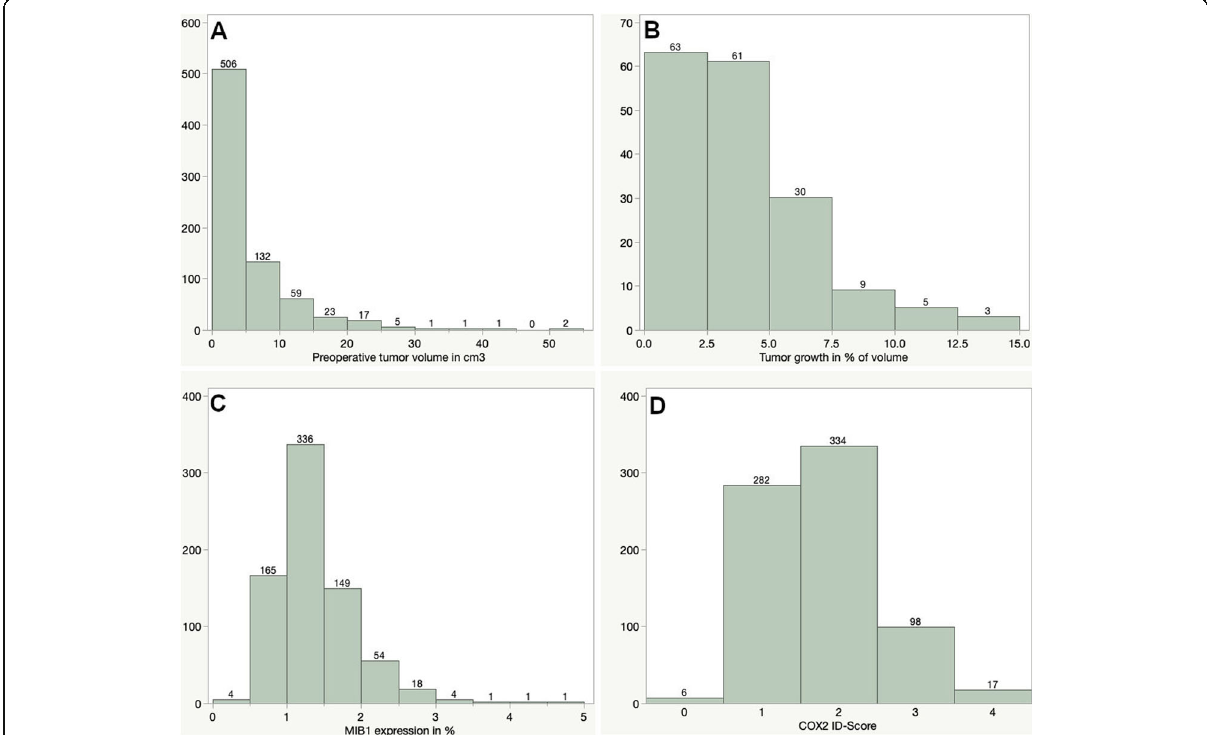
Fig. 1 Preoperative tumor volume according to gender ( a ), age ( b ), MIB1 ( c ) and COX2 expression (D and E) (ANOVA, asterisk represents statistically significant